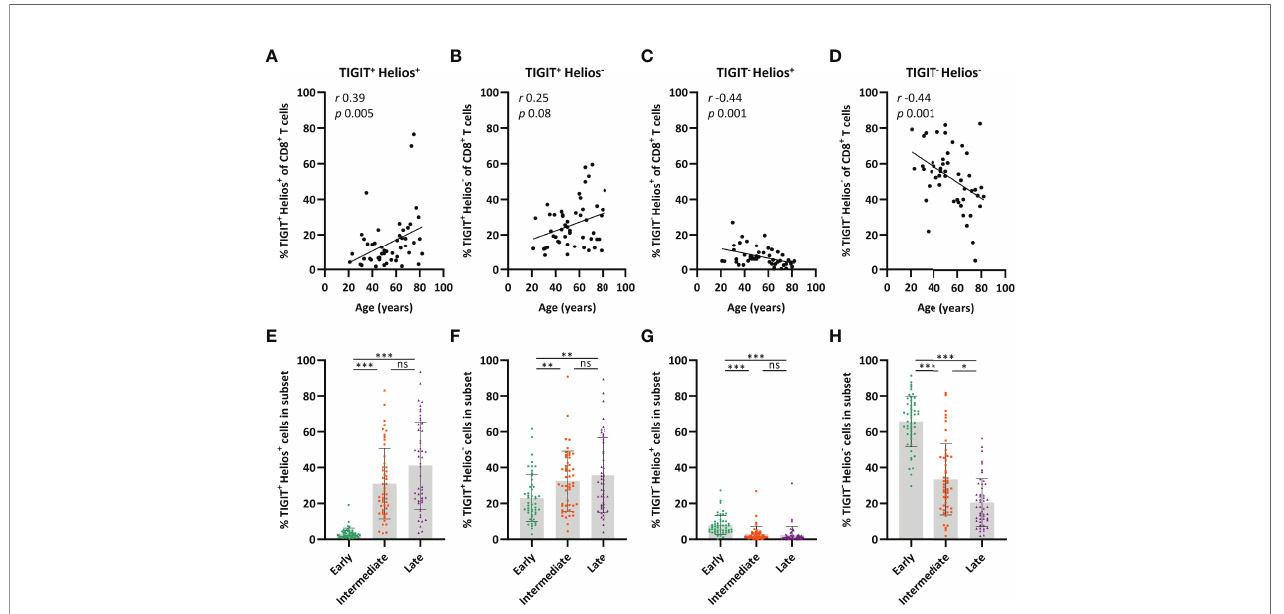
FIGURE 5 | TIGIT + Helios + cells are enriched in the intermediate- and late-differentiated CD8 + T-cell populations. Relationship between the frequency of (A) TIGIT + Helios + , (B) TIGIT + Helios - , (C) TIGIT - Helios + , and (D) TIGIT - Helios - cells within the CD8 + T-cell population and age (n = 50). Bar graphs show the frequency of (E) TIGIT + Helios + , (F) TIGIT + Helios - , (G) TIGIT - Helios + , and (H) TIGIT - Helios - cells within the early-, intermediate-, and late-differentiated cell subsets. Correlations ( r and p values) were assessed by Spearman test. Statistical signi fi cance of data presented in the bar graphs (means ± s.d.) was determined using Friedman test (with Dunn ’ s post-test). (* p < 0.05, ** p < 0.01, *** p < 0.001, ns, not signi fi